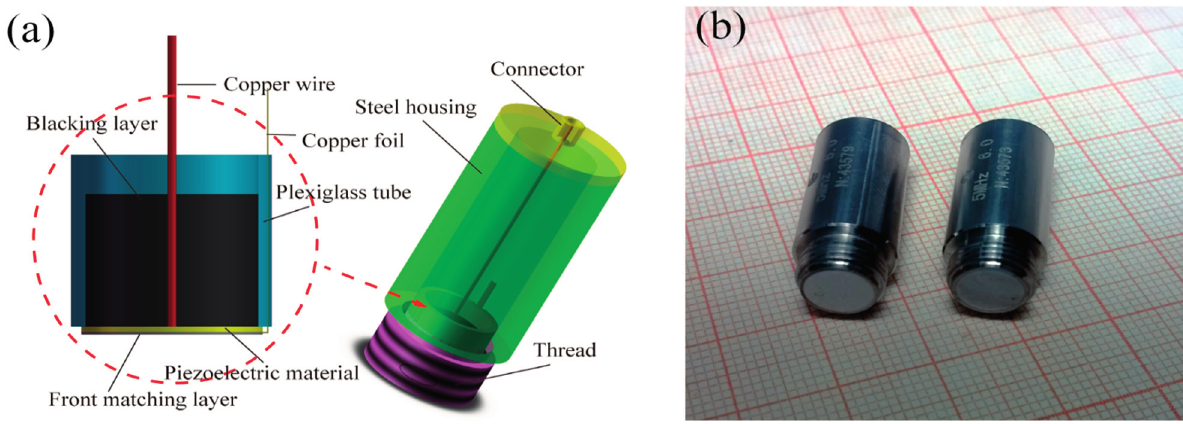
Figure 4. ( a ) Schematic diagram of the designed TOFD ultrasonic transducer; ( b ) Photograph of the fabricated TOFD ultrasonic